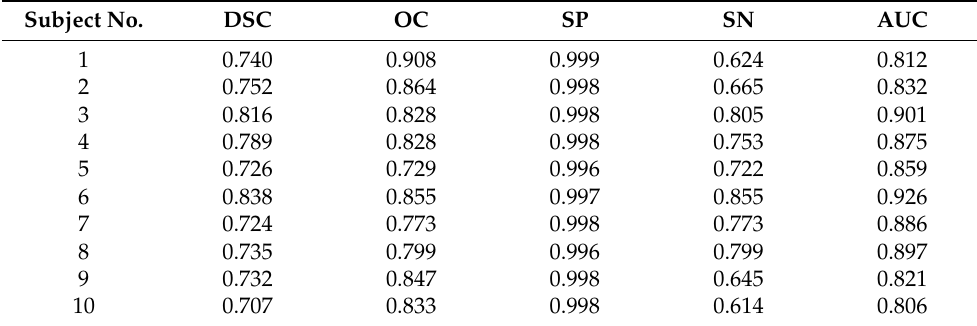
Table A1. Evaluation results for cerebellar fissures (model M1) on Hammers subset.